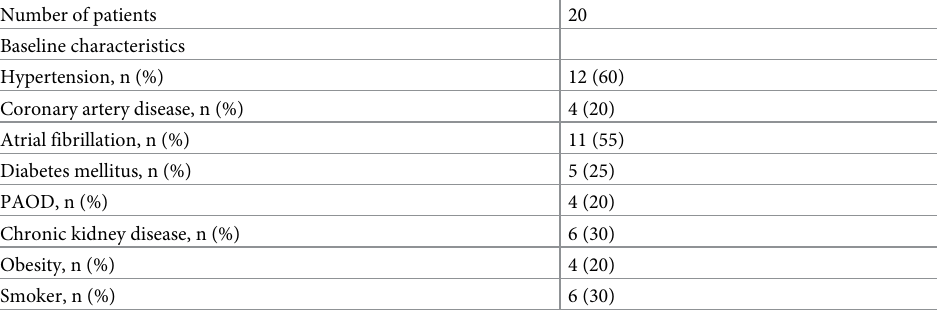
Table 1. Baseline characteristics.